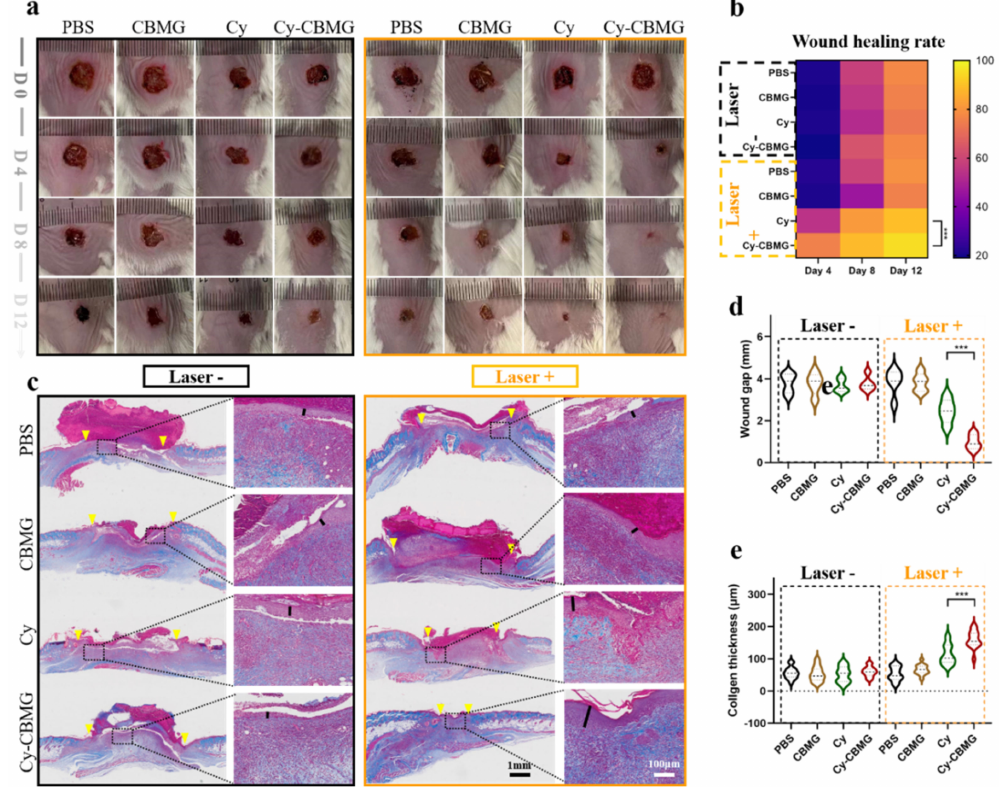
Figure 6. Wound healing evaluation after various treatments. ( a ) Representative wound area on day 0, 4, 8, 12. ( b ) The relative wound healing rate (n = 5). ( c ) Representative Masson’s trichrome staining in wound tissues. The wound gap was measured as the distance between two yellow arrows in a typical histological section. ( d ) Statistical analysis of wound gap (n = 5). ( e ) Analysis of collagen thickness, as measured upon the black line in histological sections, as showed in ( c ) (n = 5 × 3). ***: a statistically significant difference between groups, p <